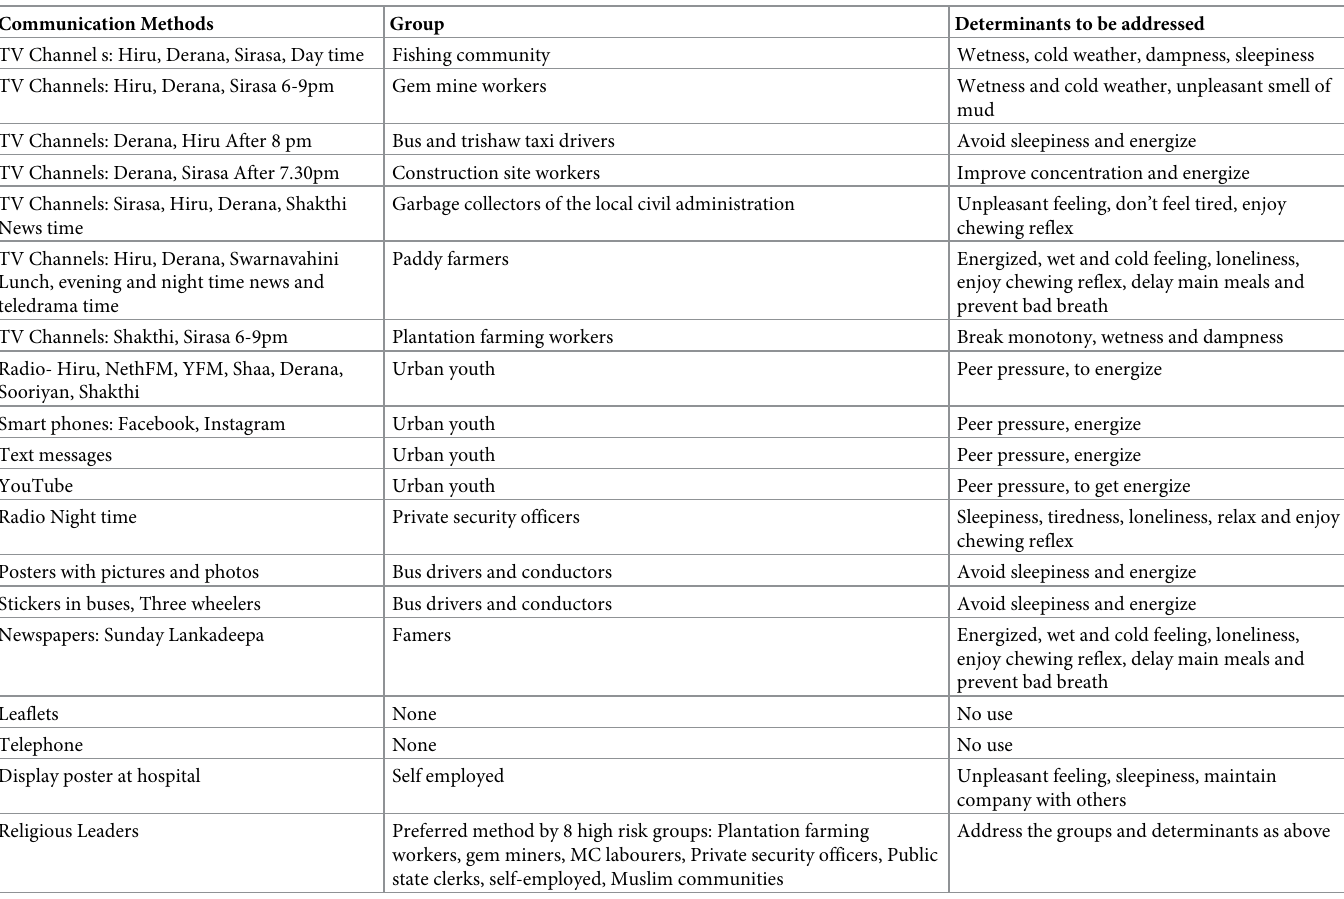
Table 3. Communication strategy. Communication Methods